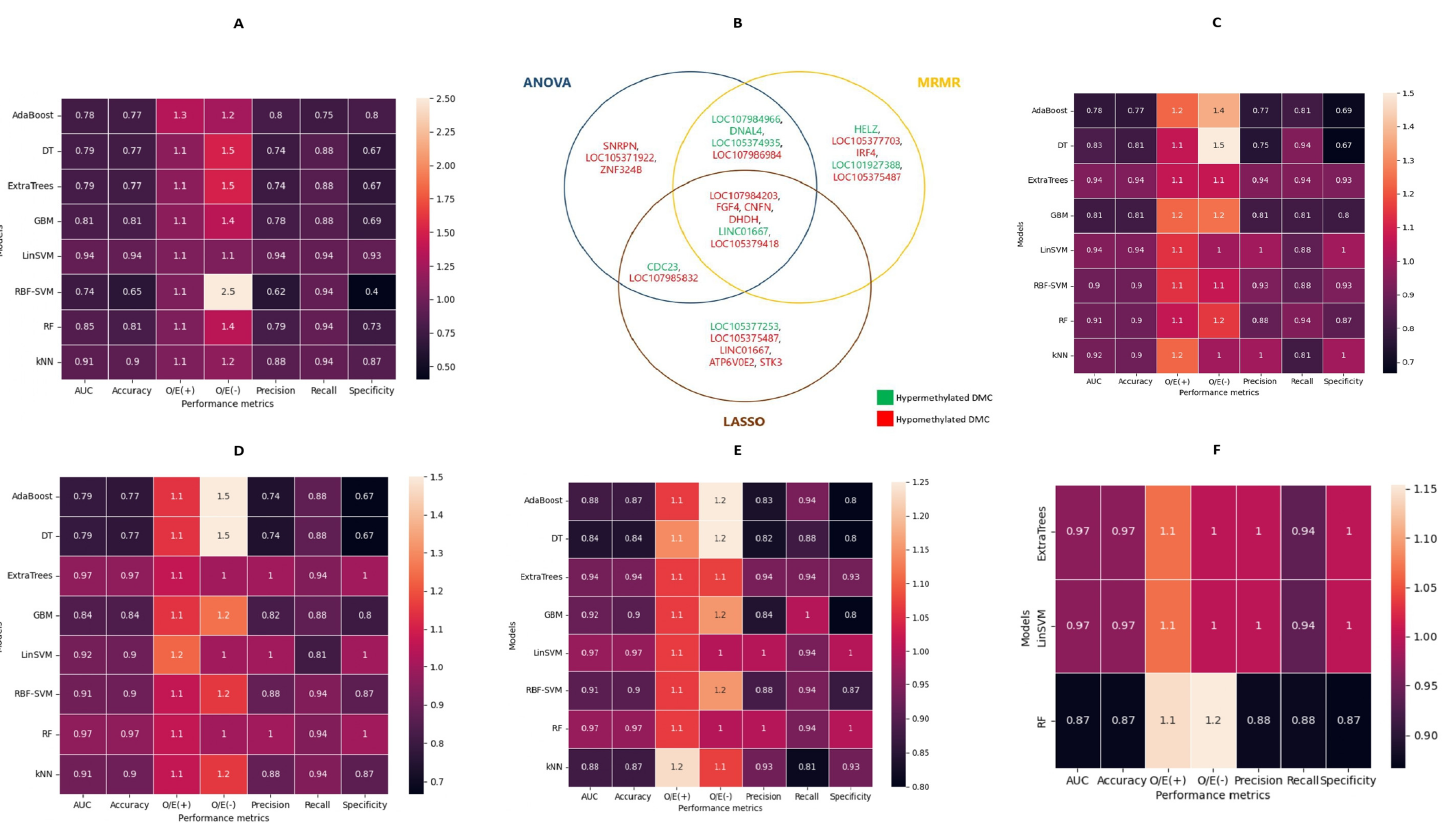
Figure 3. Performance of machine learning models for predicting OSCC using DMC as features. ( A ) Initial models comprising all 1745 DMCs. ( B ) Selected features by the three feature-selection methods and their concordance. ( C ) Machine learning models based on ANOVA-selected DMC sets for predicting OSCC. ( D ) Machine learning models based on MRMR-selected DMC sets for predicting OSCC. ( E ) Machine learning models based on LASSO-selected DMC sets for predicting OSCC. ( F ) Machine learning models based on six consensual DMCs for predicting OSCC.